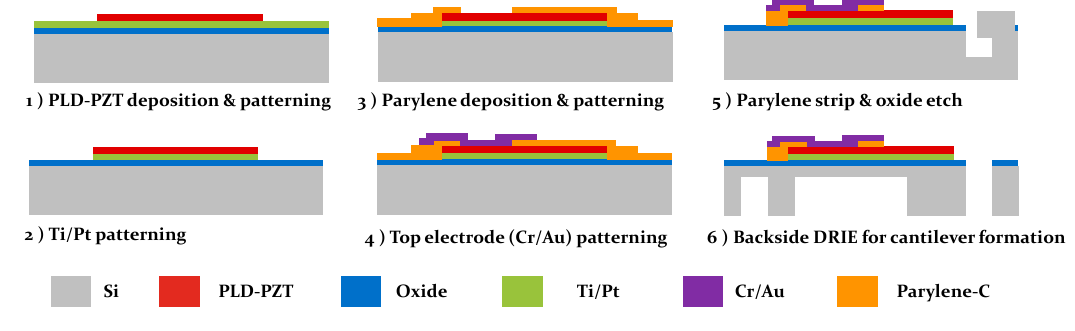
Figure 4. Fabrication flow of the thin film